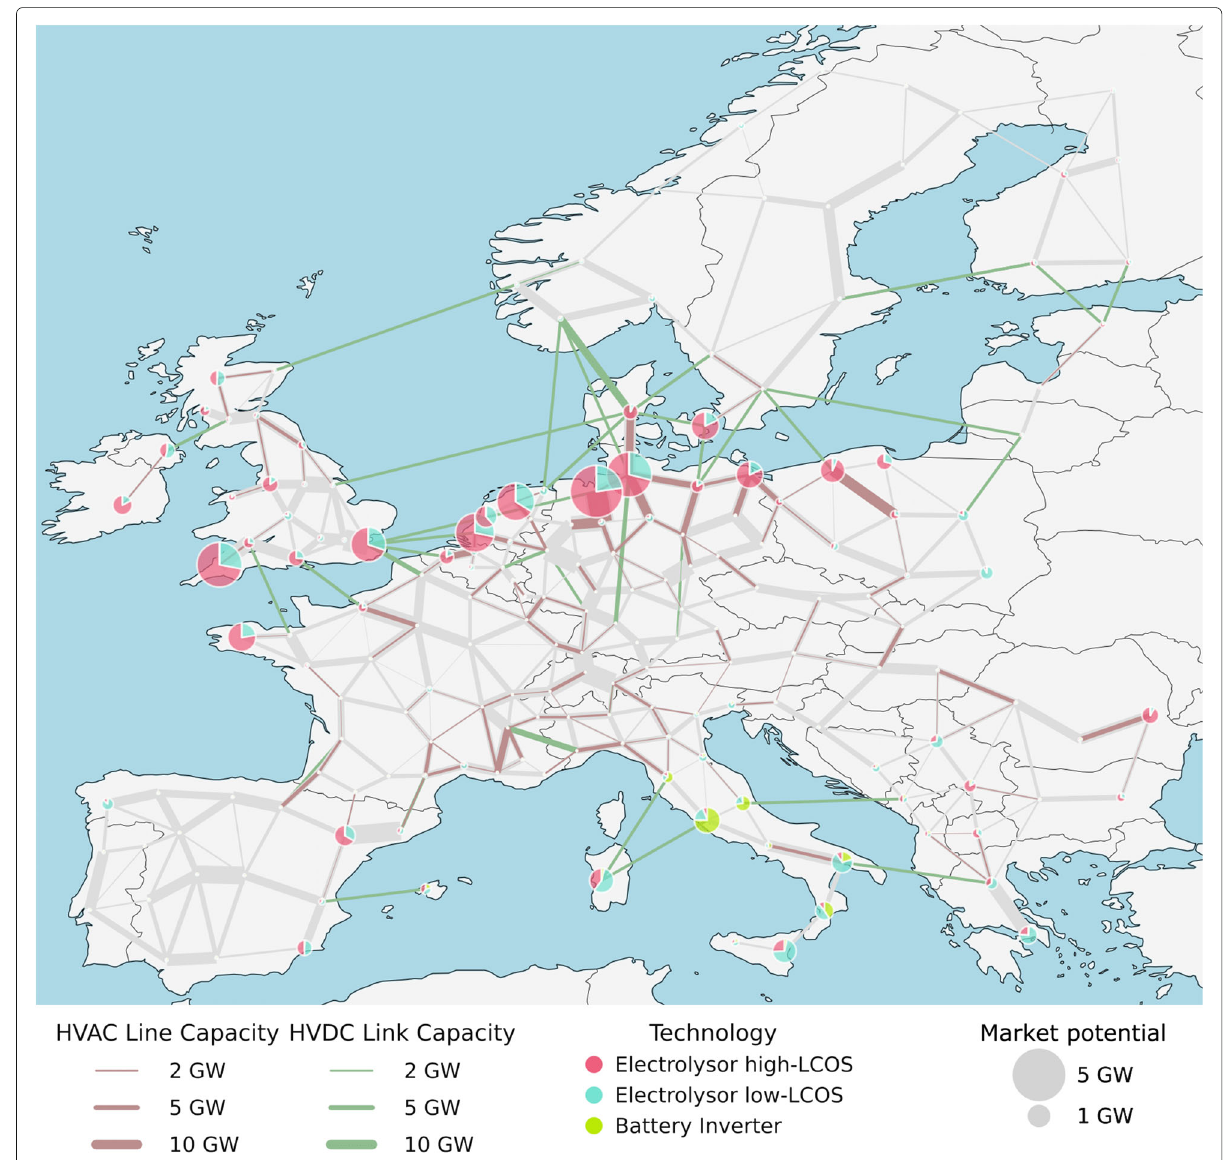
Fig. 10 Optimal energy storage charger distribution in the variable energy to power sizing scenario. Showing the location of market potential in a 100% emission reduction scenario. When compared to Figure 4, most hydrogen units are co-located with wind plants while batteries gravitate towards solar plant optimised areas